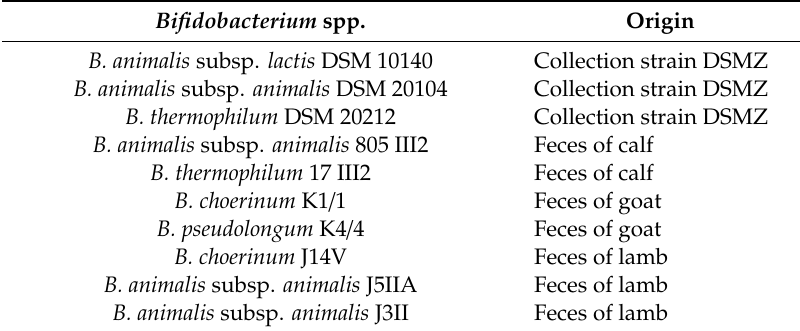
Table 1. Origin of tested Bifidobacterium